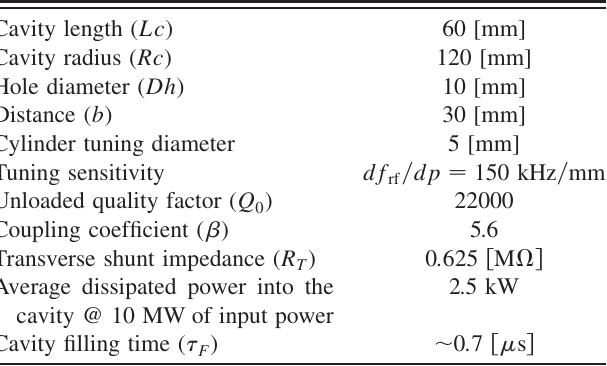
FIG. 7. (Color) Electric and magnetic field profiles on cavity axis ( HFSS TABLE III. Single cell deflecting cavity main dimensions and achieved parameters.